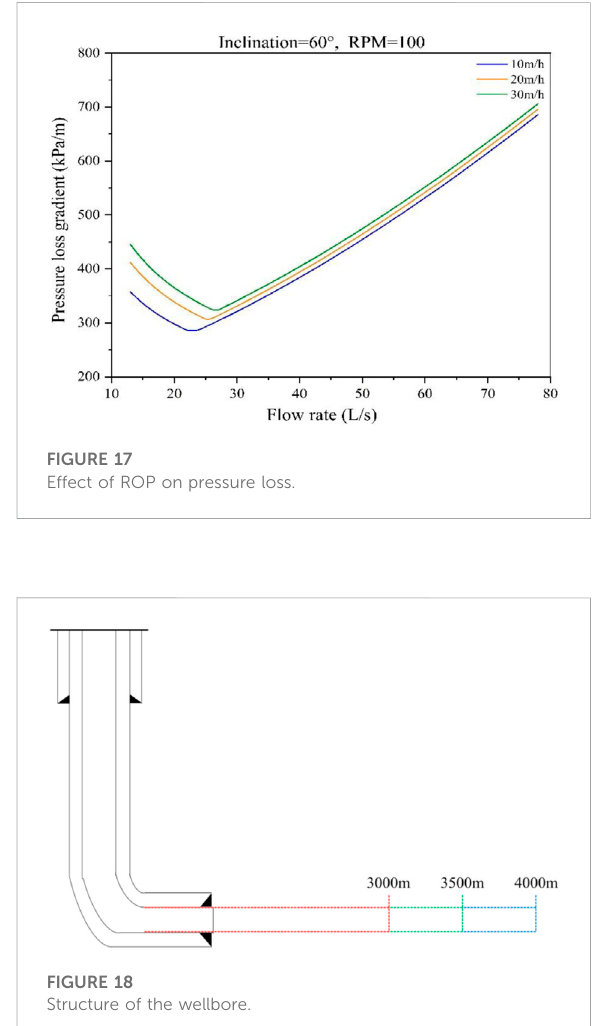
FIGURE 18 Structure of the wellbore.